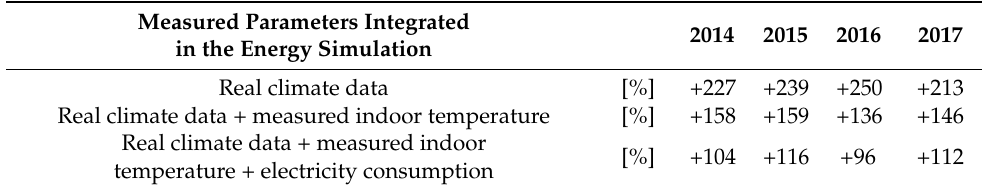
Table 4. Evolution of the energy performance gap when measured values replace the normative ones in the building energy simulation